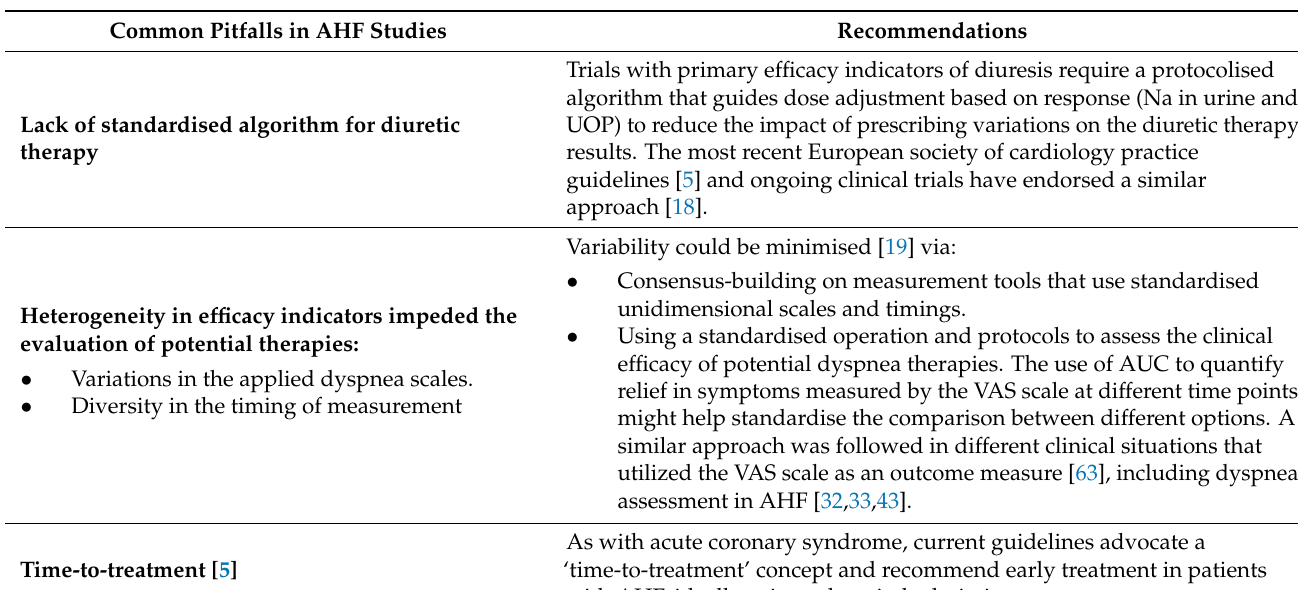
Table 4. Common pitfalls in AHF studies and evidence-based practice recommendations for inpatient treatment of